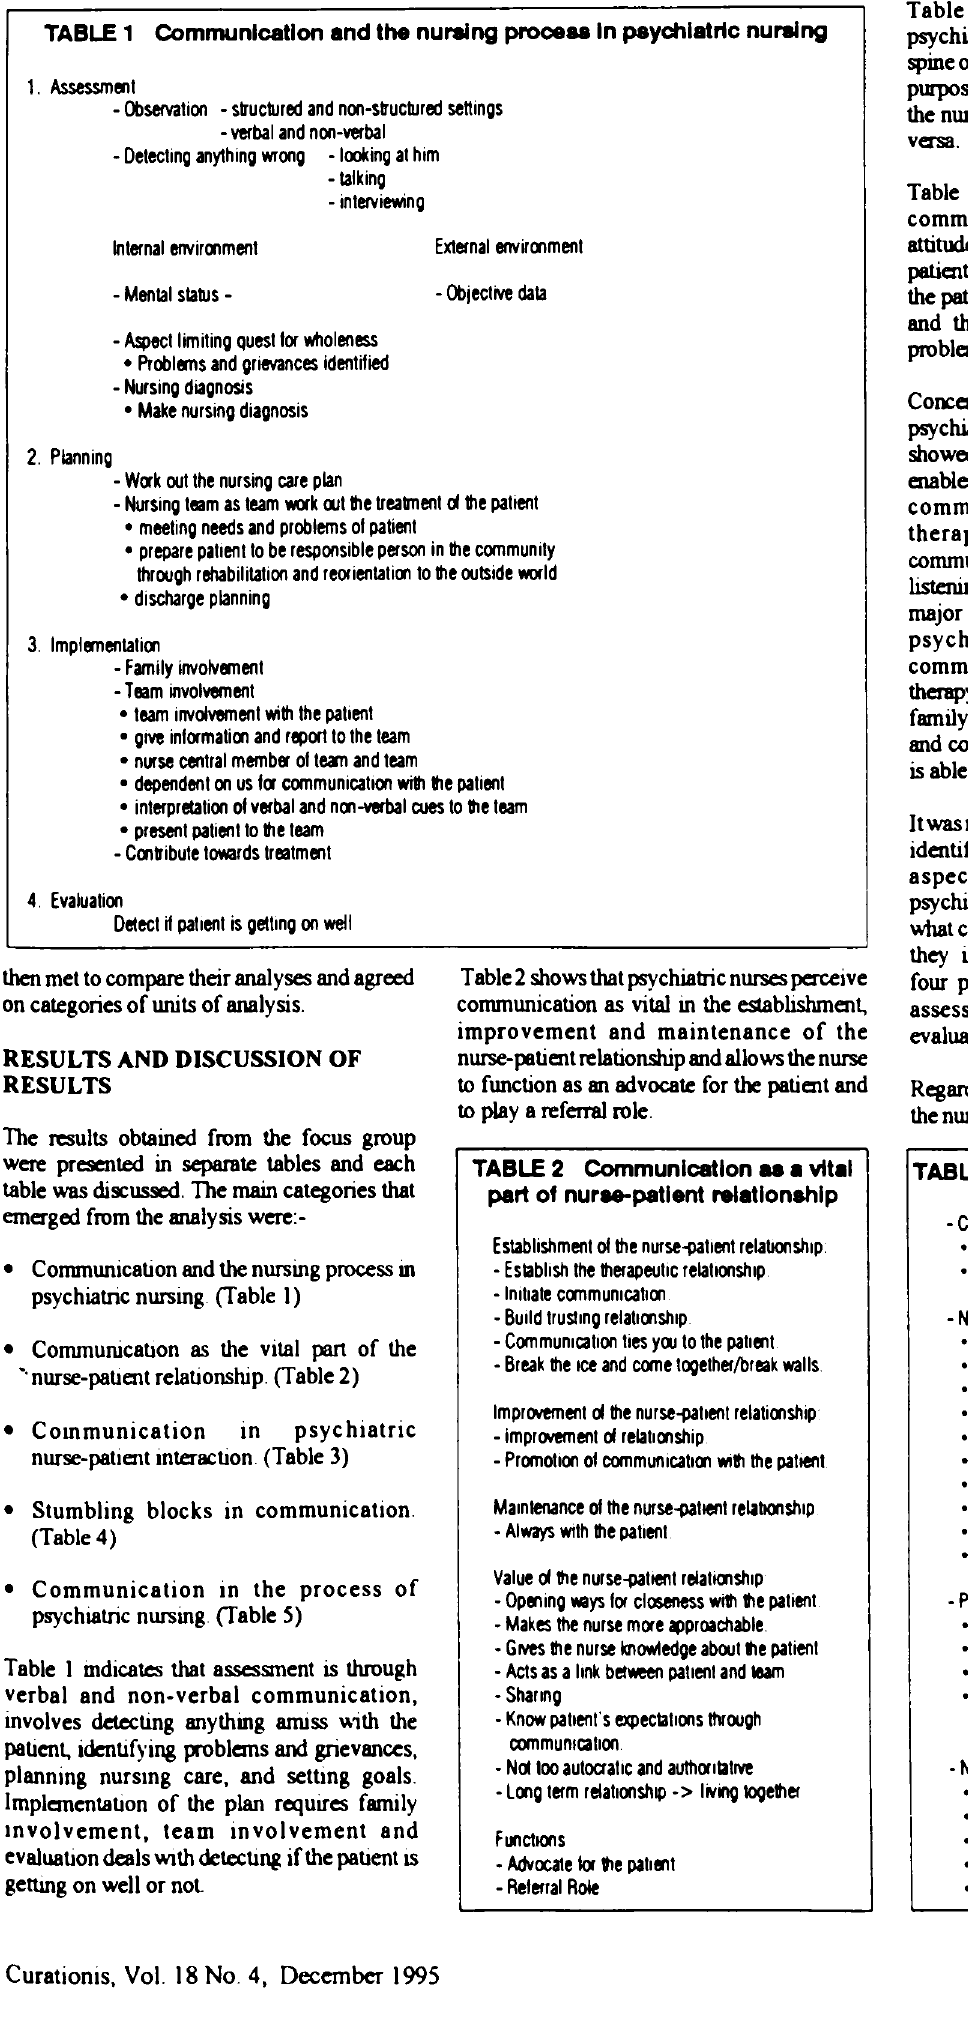
TABLE 1 Communication and the nursing process In psychiatric nursing